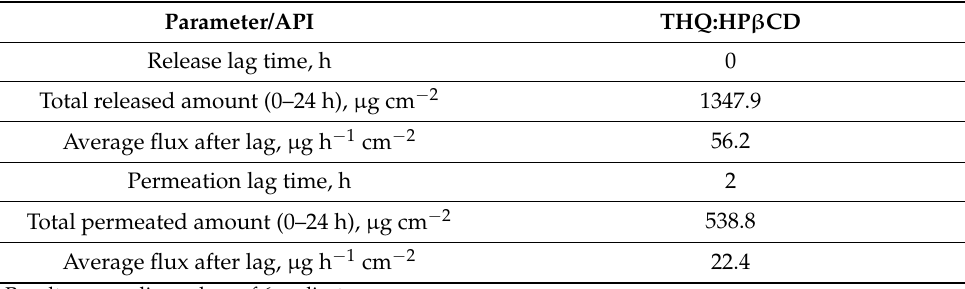
Table 3. Thymoquinone Release and Permeation values*.